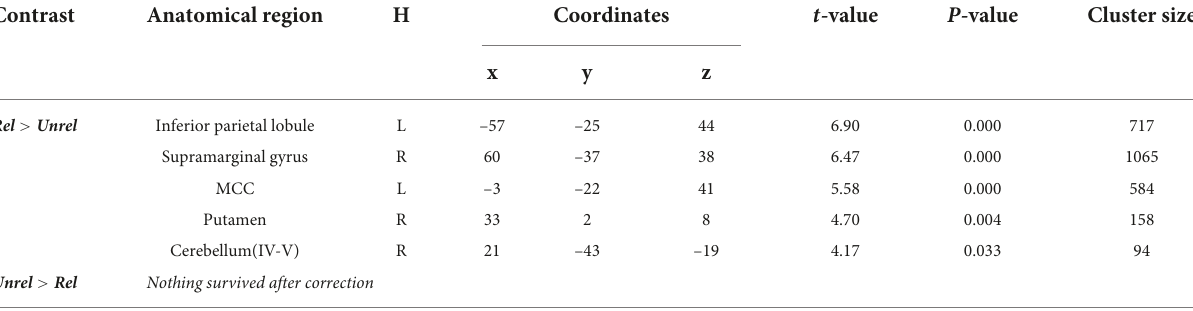
TABLE 4 Picture-word recognition: Peak coordinates of significant clusters for Related vs Unrelated contrasts. Contrast Anatomical region H Coordinates t -value P -value Cluster size